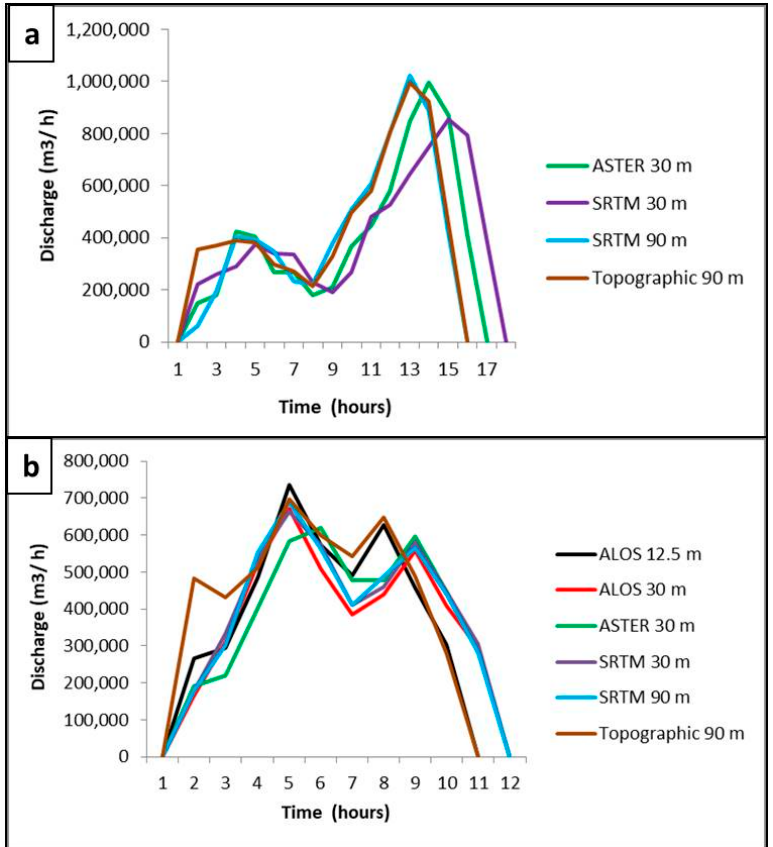
Figure 7. Simulated unit hydrographs for the Wadi Atfeh ( a ) and Wadi Al Rishrash ( b ) catchments using the estimated runoff coefficient from different DEMs.